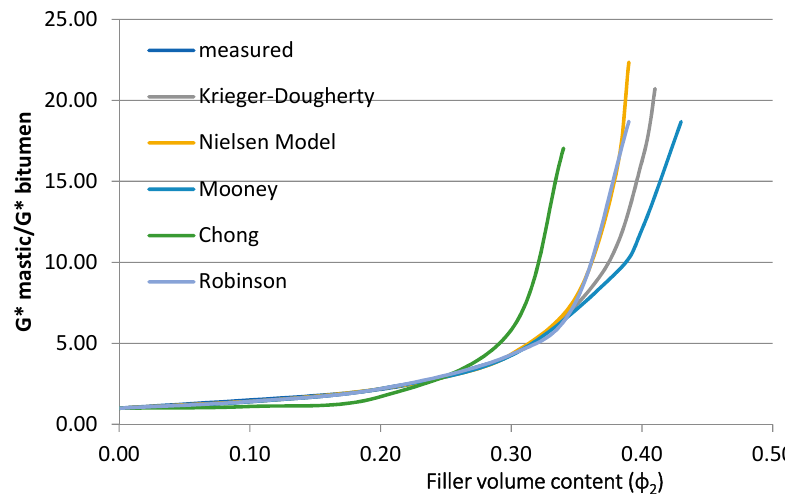
Figure 10. Micromechanics models for granite.